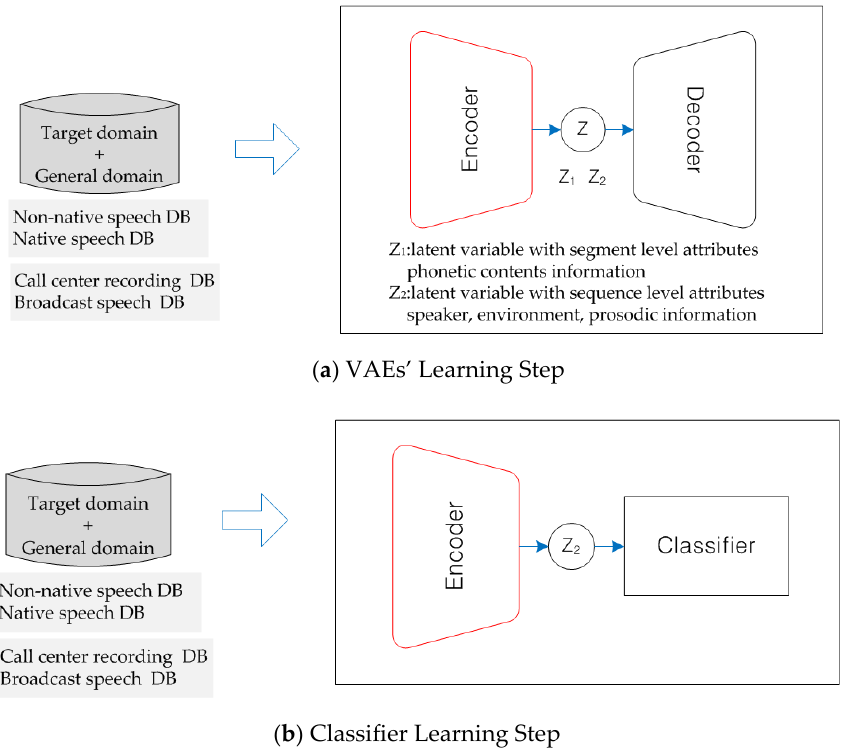
Figure 2. Graphical illustration of the learning stage of an integrated system consisting of the VAEs and classifier. The paired non-native and native speech data, and the paired call center recording and broadcast speech data, are presented as example training data.